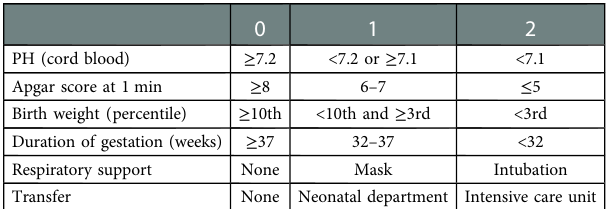
TABLE 1 Score parameters for evaluating fetal outcome